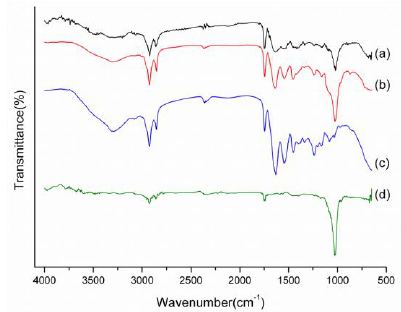
Figure 4. FTIR spectra of ( a ) nHap/Col scaffold after crosslinking; ( b ) nHap/Col scaffold without crosslinking; ( c ) pure collagen (Col); and ( d ) hydroxyapatite (Hap) materials.